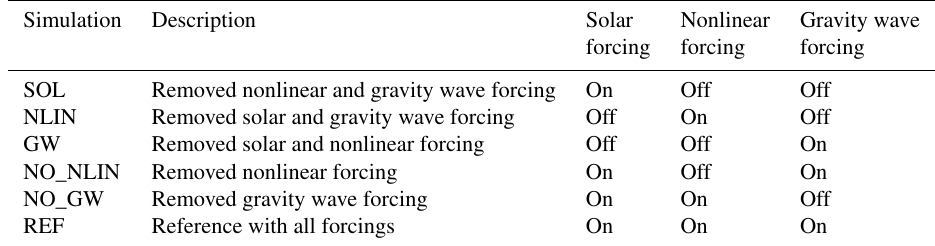
Table 1. Overview on the different model experiments. Simulation Description Solar Nonlinear Gravity wave forcing forcing forcing SOL Removed nonlinear and gravity wave forcing On Off Off NLIN Removed solar and gravity wave forcing Off On Off GW Removed solar and nonlinear forcing Off Off On NO_NLIN Removed nonlinear forcing On Off On NO_GW Removed gravity wave forcing On On Off REF Reference with all forcings On On